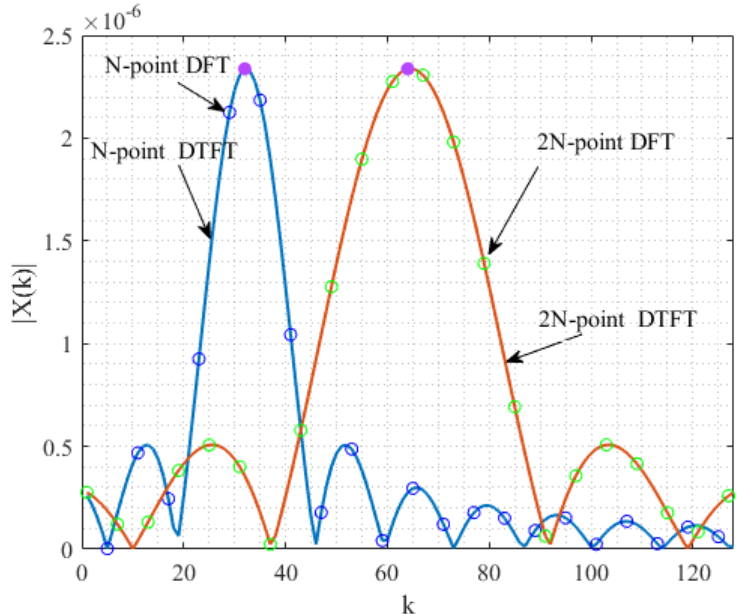
Figure 3. DFTs and DTFTs of complex exponential signals at M = N and M = 2 N